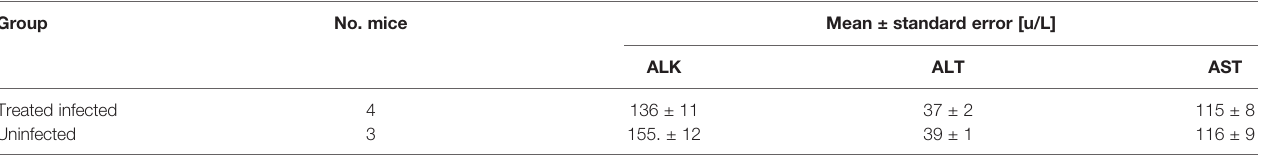
TABLE 4 | The effect of treatment on liver function of convalescent mice. Group No.